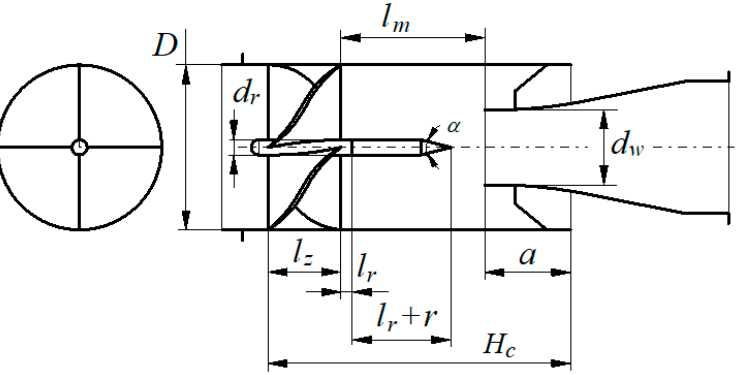
Figure 10. Cyclone modification C—change of the core length in relation to its original value.